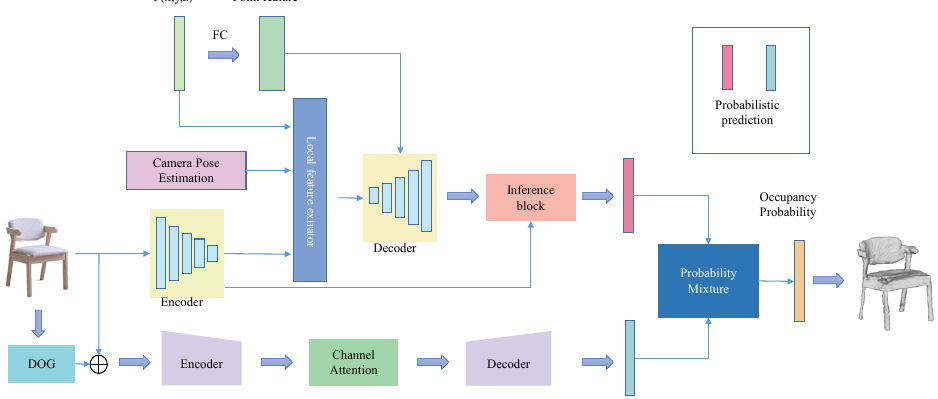
Figure 2. 3D reconstruction of the network structure.